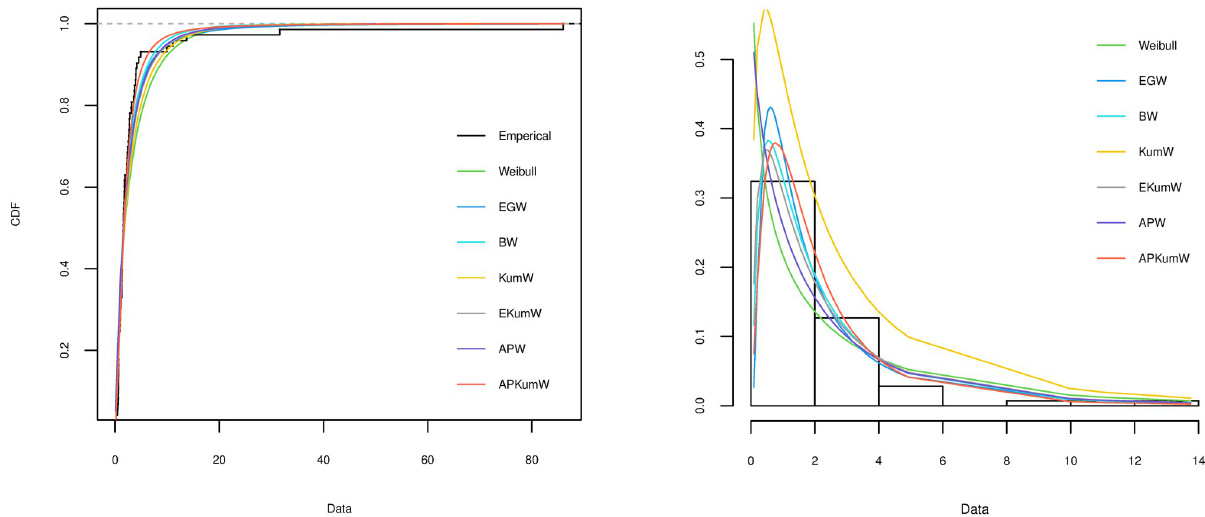
Fig 2. Theoretical and empirical cdf and pdf comparison of the acute bone cancer